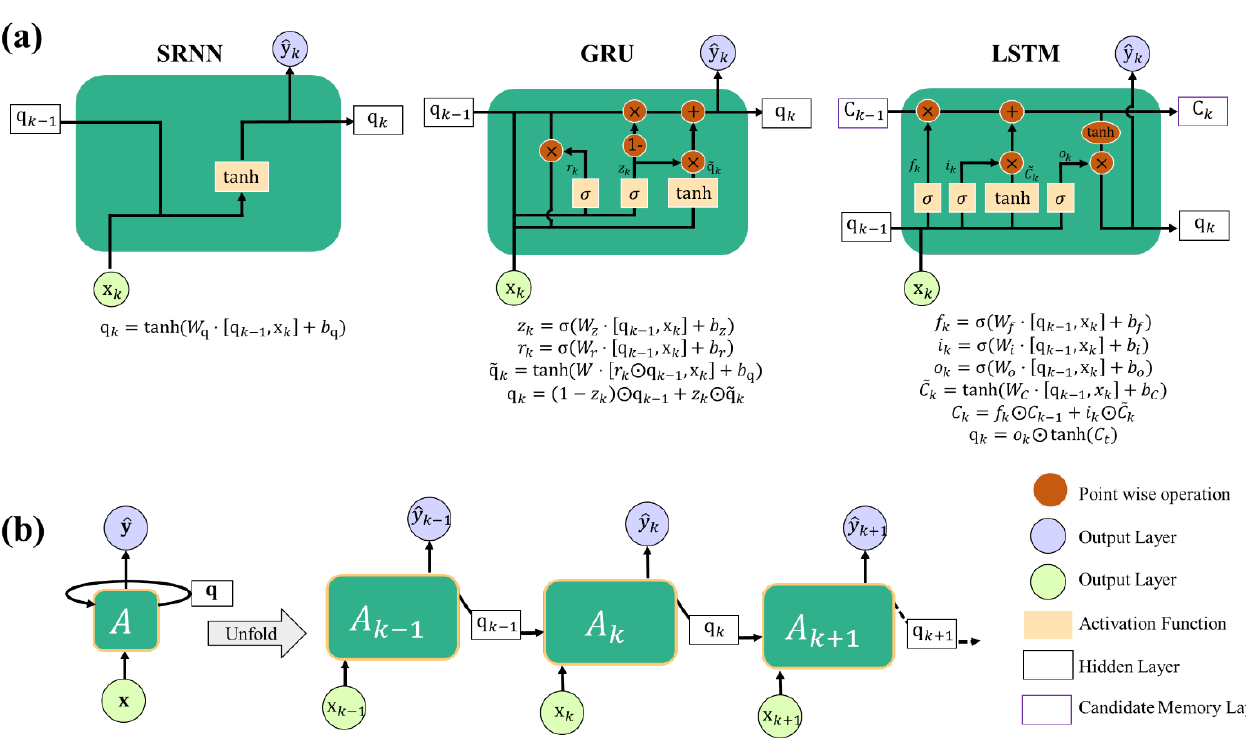
Figure 2. Three types of vanilla Recurrent Neural Network cells: ( a ) Simple Recurrent Neural Network (SRNN), Gate Recurrent Unit (GRU), and Long Short-Term Memory (LSTM); ( b ) an unfolded standard Recurrent Neural Network in repeating module: The right-hand side schematic is the unfolding version of neural network A through time. Here, 𝐱 and 𝐲̂ represent input, and the output vectors for the k -th state, while q represents the hidden state. This paper uses bold forms to represent vectors.